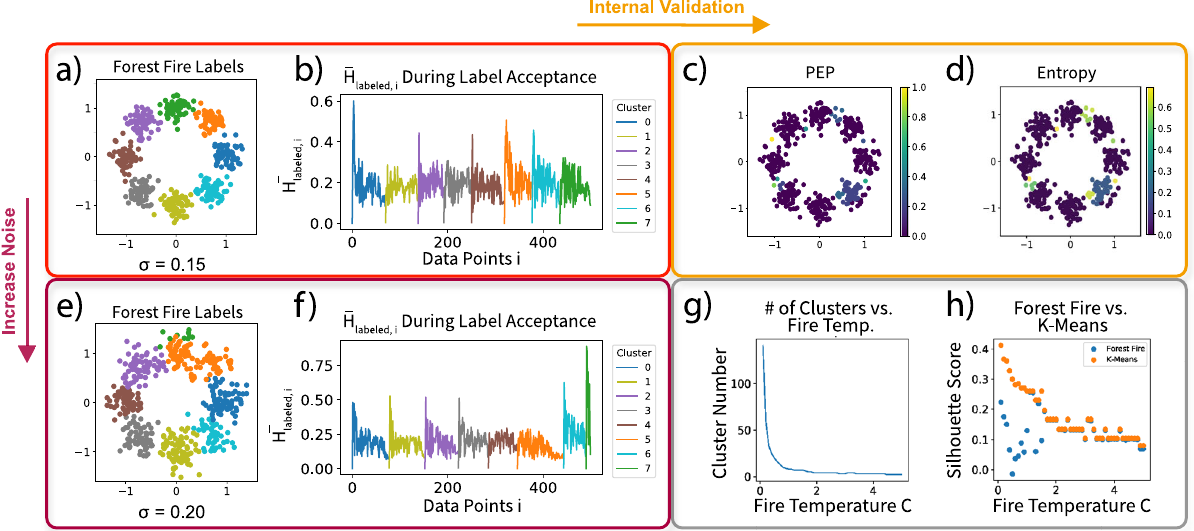
Fig. 2 Visualizing the Forest Fire Clustering process with Gaussian mixture models. a Forest Fire Clustering labels on Gaussian mixtures ( σ = 0.15) centered on the unit circle. b Average heat (cid:1) H labeled ; i during label acceptance plot when σ = 0.15. c Posterior exclusion probability (PEP) of the Forest Fire labels on Gaussian mixtures from part ( a ). d Entropy of the Forest Fire labels on Gaussian mixtures from part ( a ). e Forest Fire Clustering labels on Gaussian mixtures ( σ = 0.20) centered on the unit circle. f Average heat (cid:1) H labeled ; i during label acceptance plot when σ = 0.20. g The number of clusters found in the data decreases as the fi re temperature increases. h Silhouette score of Forest Fire Clustering vs. K -means clustering on Gaussian mixtures from part ( a